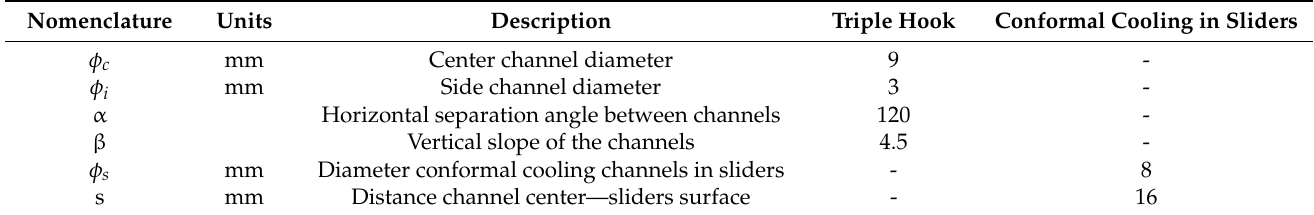
Figure 8. Complete cooling of the cavity, core and sliders of the injection mold por the presented optical part. Table 1. Geometric parameters used in the design of conformal cooling